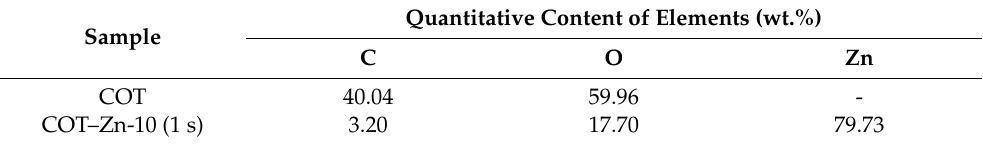
Table 3. Quantitative content of elements in individual samples based on the EDS test.